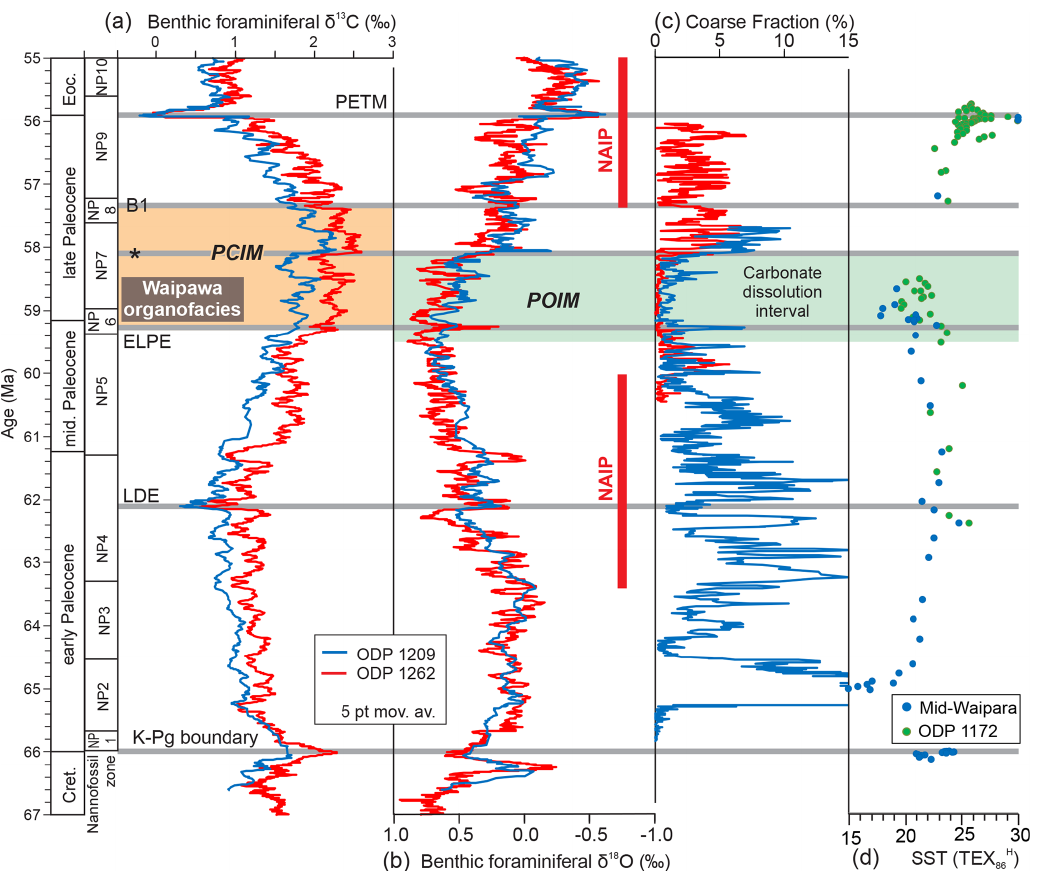
Figure 1. Paleocene variation in benthic foraminiferal carbon (a) and oxygen (b) stable isotopes and sediment coarse-fraction ( > 63µm) percentage (c) for ODP sites 1209 and 1262 (from Barnet et al., 2019) compared with (d) variation in TEX H ODP Site 1172 and the mid-Waipara River section (from Hollis et al., 2012, 2014, 2019). Climatic and biotic events highlighted are the Cretaceous–Paleogene (K–Pg) boundary, Late Danian Event (LDE), early late Paleocene event (ELPE), Paleocene oxygen isotope maximum (POIM), Paleocene carbon isotope maximum (PCIM) and Paleocene–Eocene Thermal Maximum (PETM). Timing of the North Atlantic Igneous Province (NAIP) eruptive phases and Waipawa organofacies deposition is also